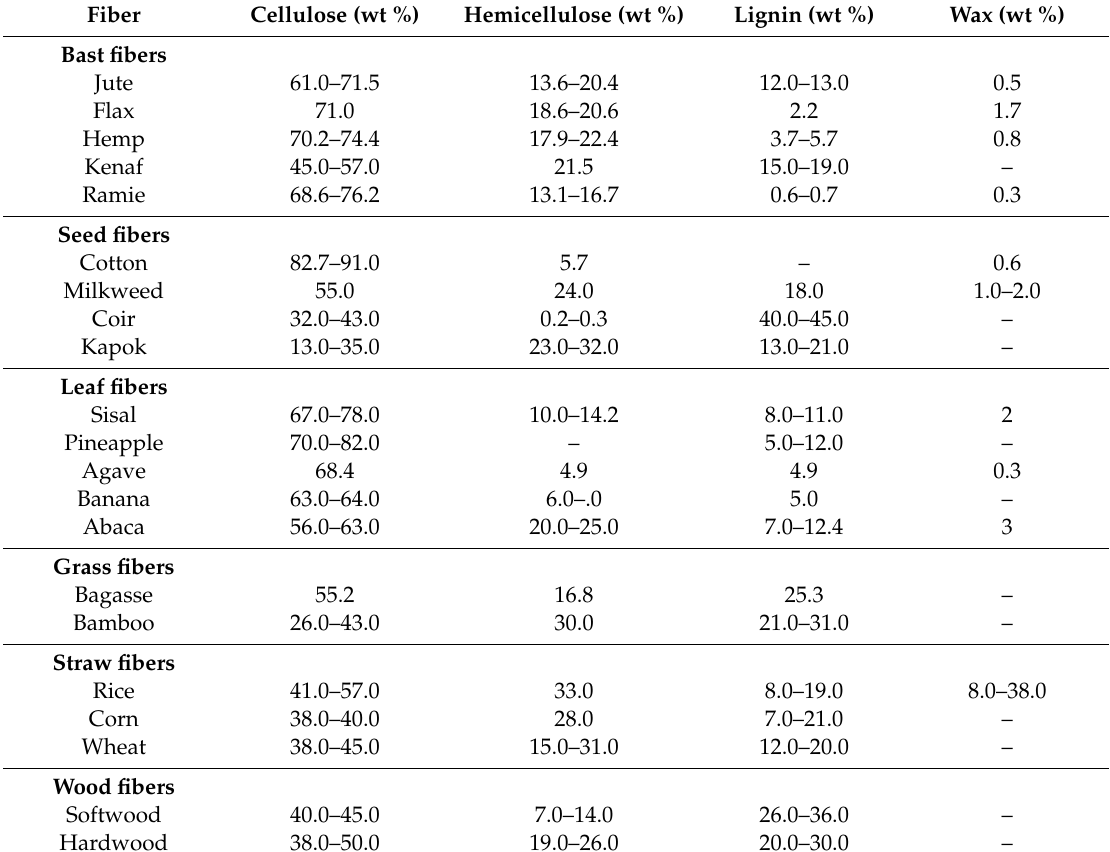
Table 3. Chemical composition of some of the most common natural fibers (adapted from